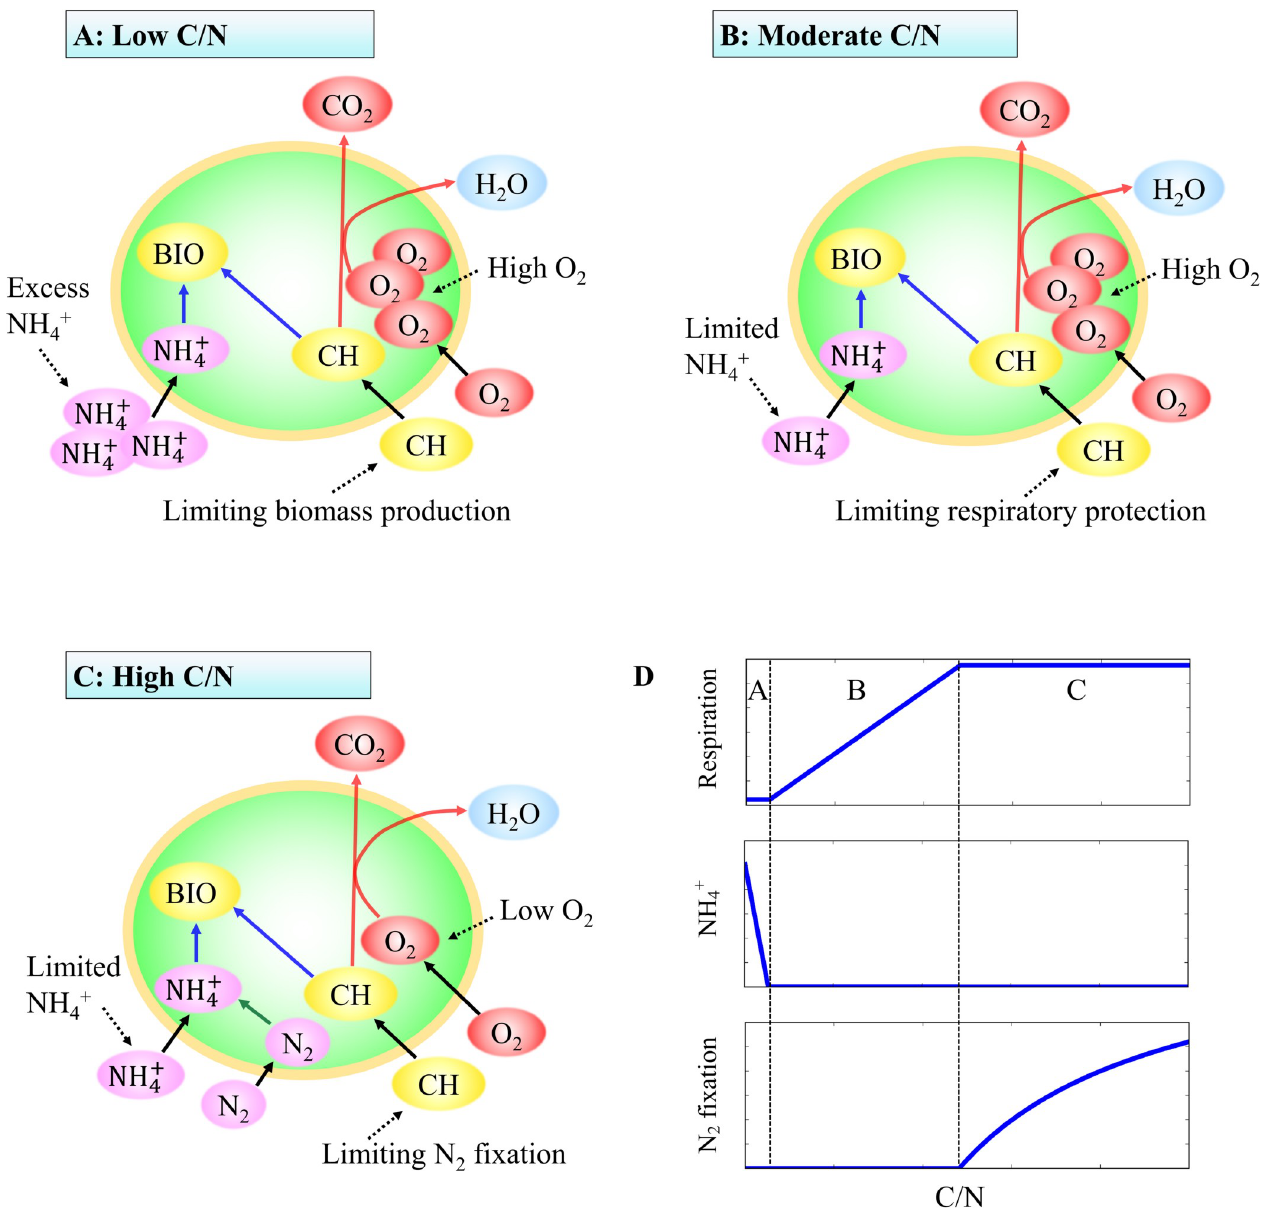
Fig 5. Nitrogen metabolism at different C/N ratios. As C/N ratio increases the cell metabolism shifts from carbohydrate limitation at low C/N supply (A), to ammonium limitation at moderate C/N (B) then to combined ammonium assimilation and nitrogen fixation at high C/N supply which is also carbon limited provided the N 2 concentration is sufficiently high (C). Black arrows, nutrient uptake; red arrows, respiration; blue arrows, biomass production; green arrow, nitrogen fixation. CH and BIO indicate the intermediate intracellular store of carbohydrate and cellular biomass, respectively. Respiration per unit protein, the ammonium concentration in the medium and nitrogen fixation rate per protein transitions in three phases are shown in